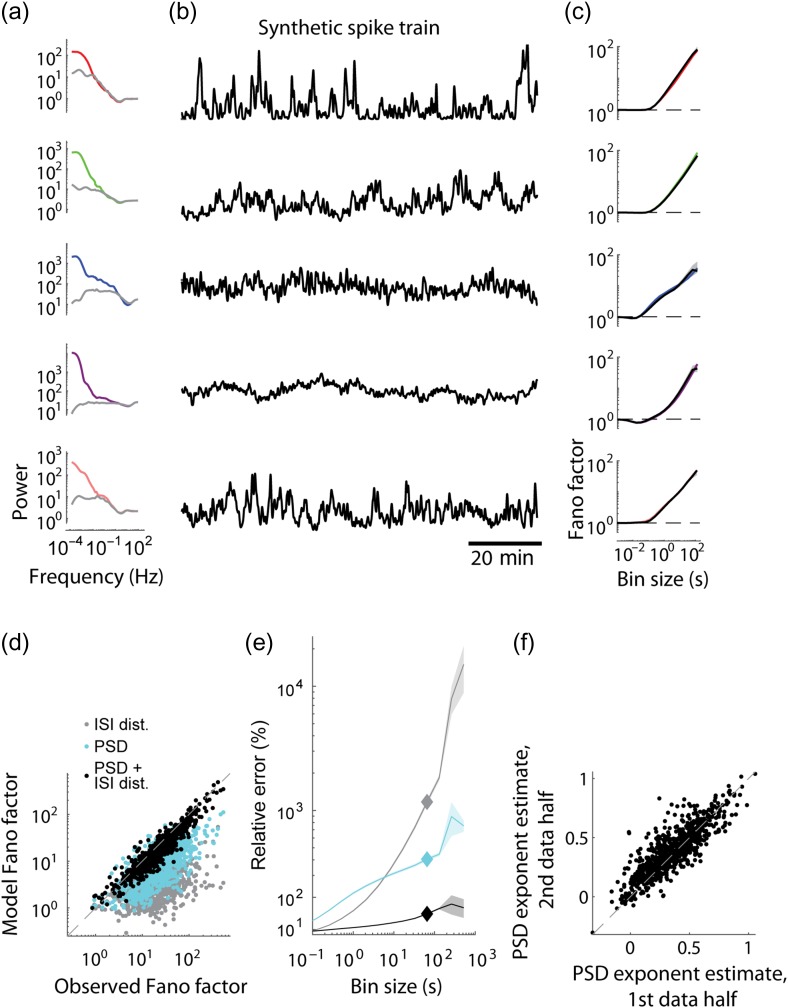
Modeling spiking dynamics on fast and slow timescales. (a) PSD of the original (color) and ISI-shuffled (gray) spike trains for the 5 example neurons shown in Figure 1. (b) Firing rate of synthetic spike trains constructed by requiring that their ISI distribution and PSD match the original data (cf. Fig. 1b,c). (c) Fano factors of spike counts using bins of 10−3–102 s: the plots for original data (color) and for synthetic spike trains (black) closely match (cf. Fig. 1d). Shaded areas (where visible) indicate 95% confidence intervals. (d) Observed and predicted spike count Fano factors for 65 s bins for the entire dataset (775 neurons). Predictions were based on ISI distribution only (gray), on PSD only (cyan), or on the full model in which both constraints apply (black). (e) Relative error (in %) of predicting the observed Fano factors for bins of 10−3–102 s for the 3 models, averaged over all neurons. Diamonds mark values for 65 s bin, shown in d (1072%, 305%, and 47% errors of ISI only, PSD only and the full models, averaged across all neurons). Shaded area shows the standard error. (f) The PSD of each neuron was fit with a const/fβ function in the range 0.01–1 Hz. The power-law exponent β is specific to each neuron, which is demonstrated by the fact that the values estimated separately in 2 halves of the recording closely match (R2 = 0.69, P < 10−100).